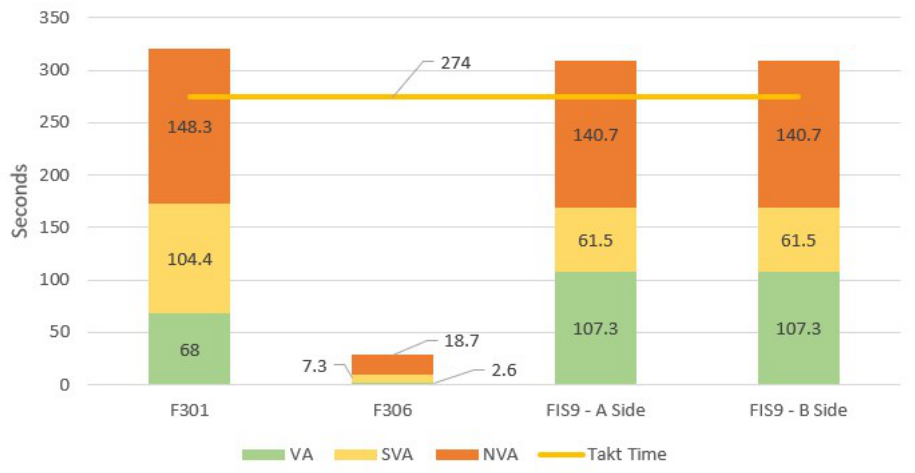
Figure 7. Yamazumi graph representing the impact, in seconds, of VA, SVA, and NVA operations on the total assembly time for every